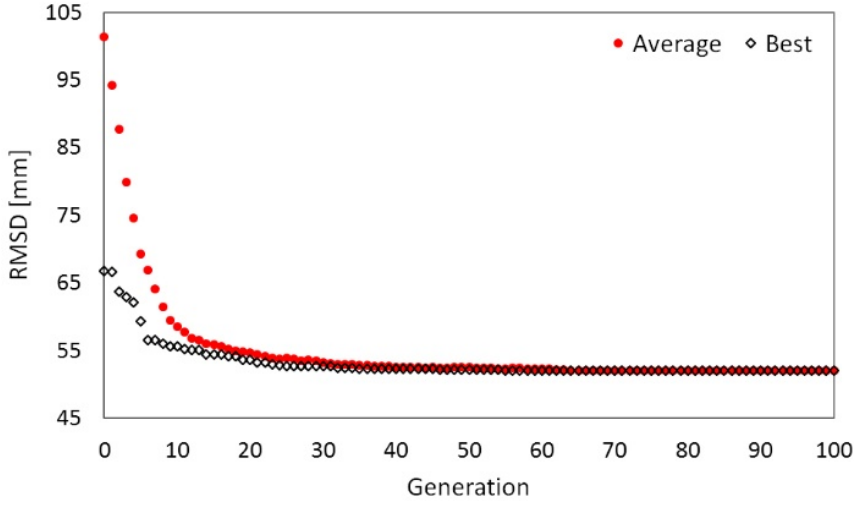
Figure 8. Variation of RMSD with each generation during genetic algorithm optimization for a bat made of sugar maple. Table 2. Optimization parameters for the baseline, GA and hybrid optimized design.